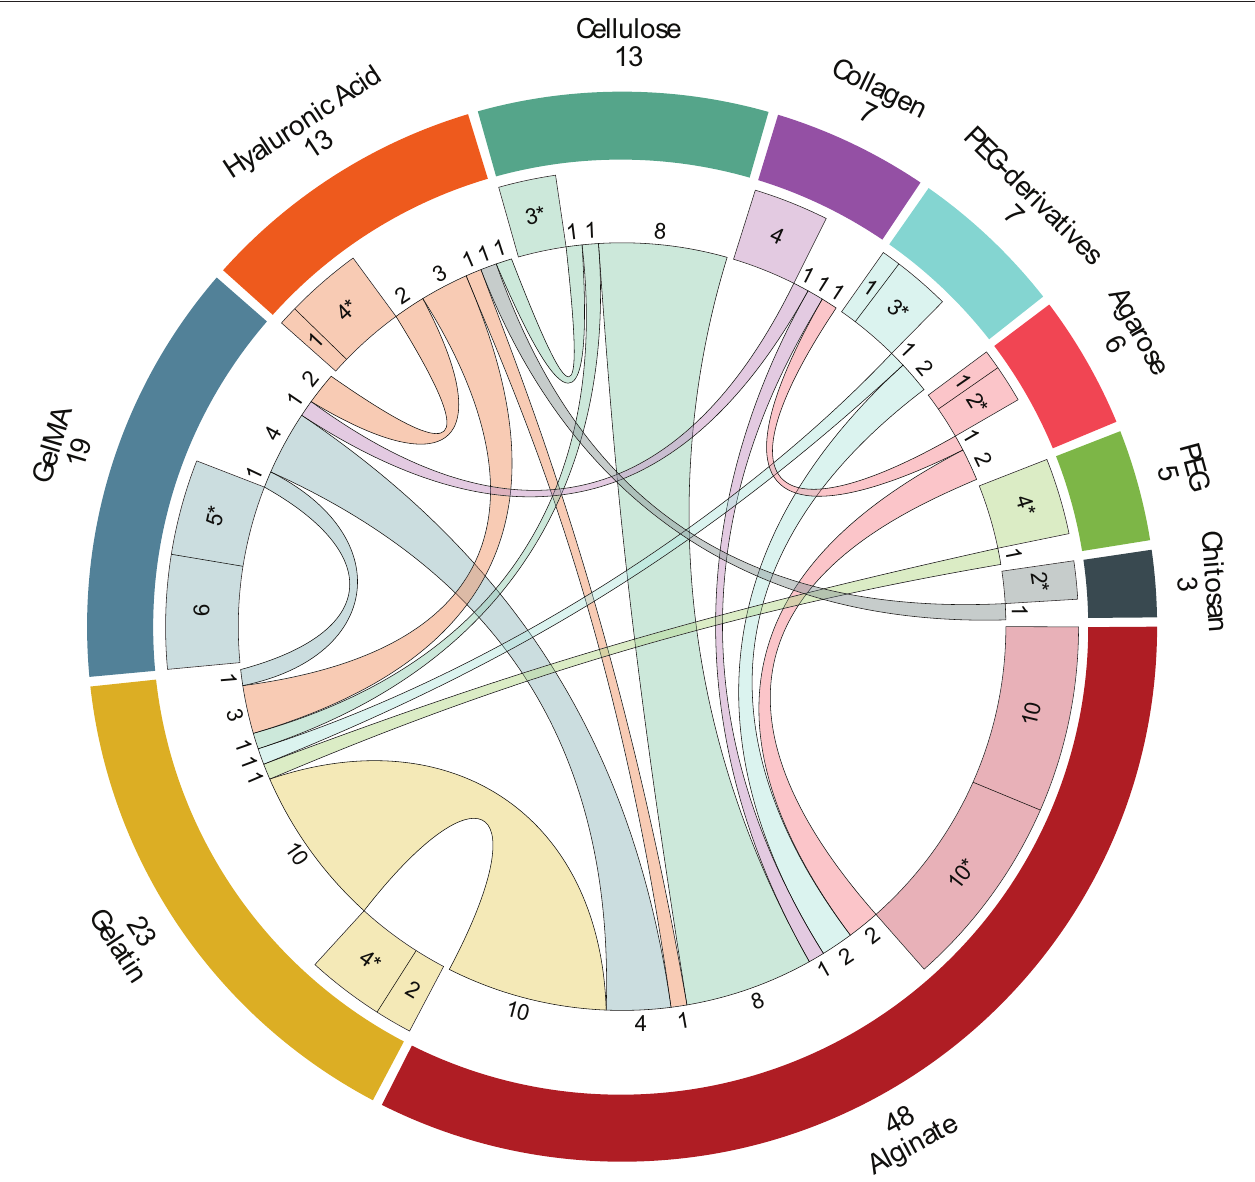
FIGURE 6 | Combination of the 10 most used materials in hydrogels among them. The materials are shown in the external ring (total of papers and name). The middle ring segments represent one-material hydrogels and hydrogels, marked with (*), that are a combination of this material with non-selected materials (one-material papers mixed with non-selected materials papers). Inner lines represent hydrogels with two of the selected materials, but in some case other non-selected materials can be included (number of papers next to each inner